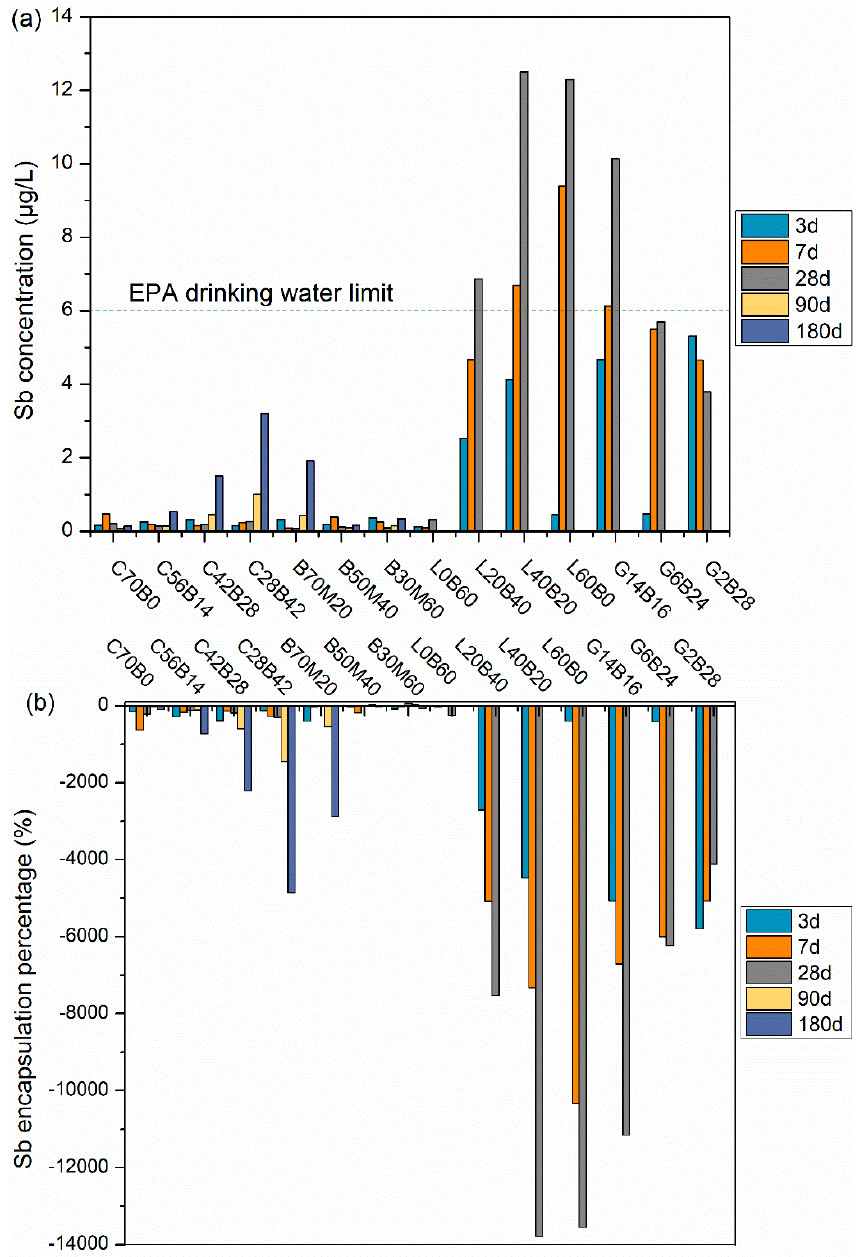
Figure 9. The ( a ) Sb concentration and ( b ) encapsulation percentage for the leachate in all groups at all ages.